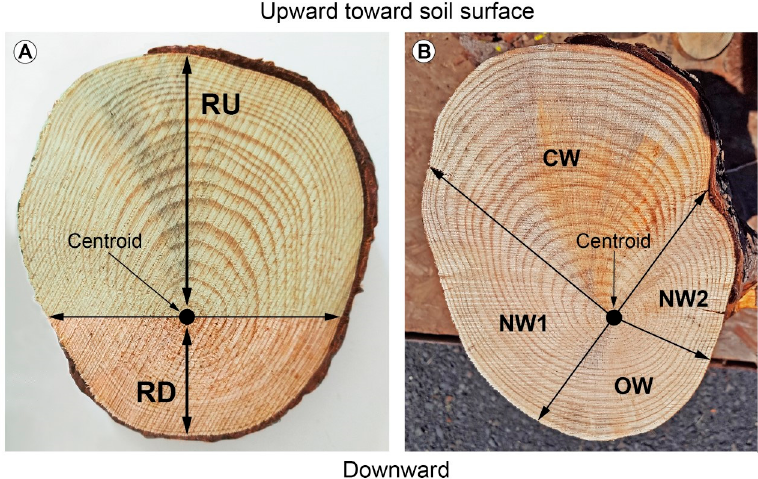
Figure 2. ( A ) Cross-sectional area was determined using software ImageJ. The first radius, RU, extended from the centroid of the section (the position of the oldest annual ring) upward toward the soil surface, whereas the second radius, RD, extended from the centroid downward, away from the soil surface. A transversal line through the centroid divided the cross-section into the top (light brown) and bottom (dark brown) portion of the wood section. ( B ) Compression wood (CW) occurred reverse of opposite wood (OW); these zones were separated by areas of normal wood (NW).